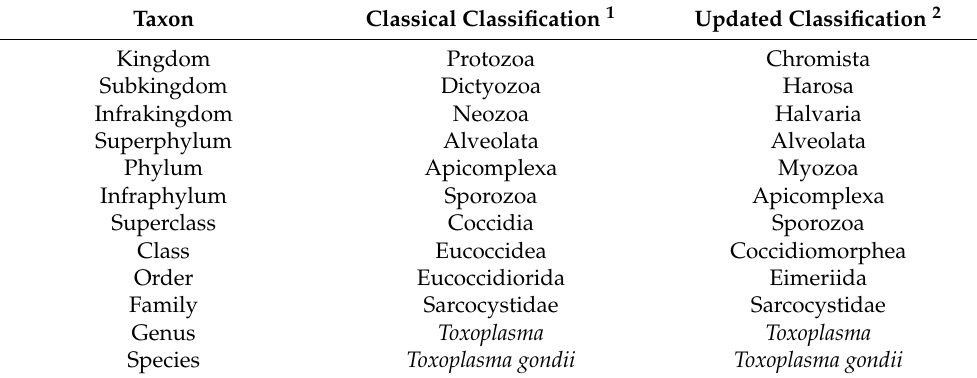
Table 1. Comparison of classical and updated taxonomic classifications of Toxoplasma gondii